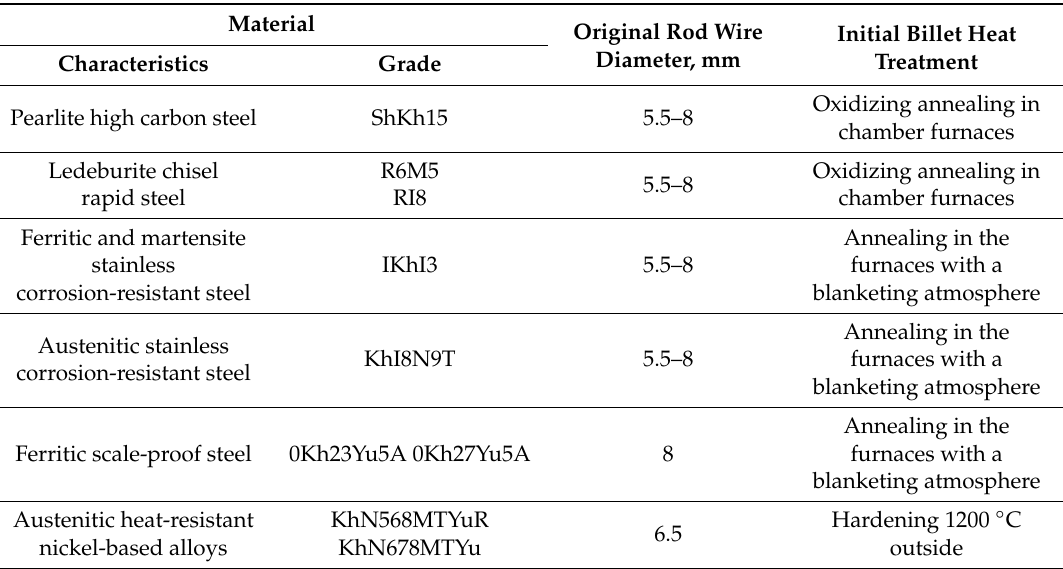
Table 2. Main steel grades and alloys used in the